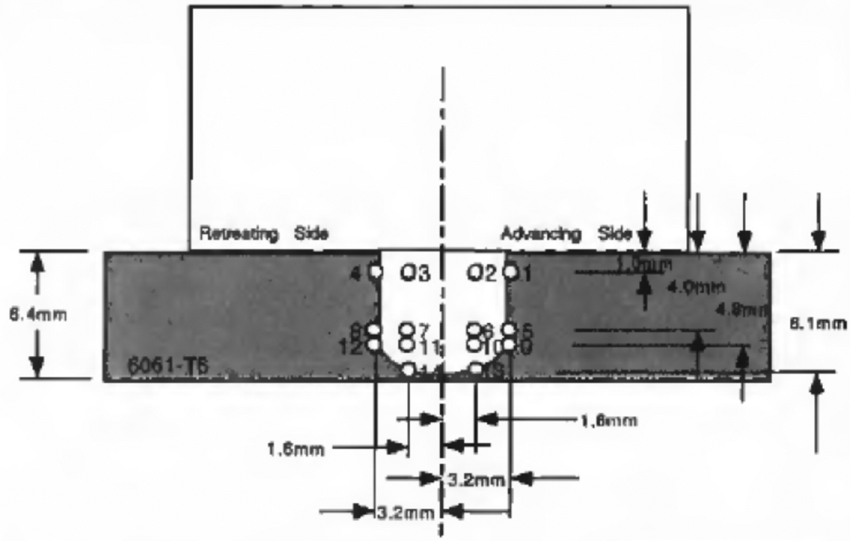
Figure 5: Tracer line positions for the 6.4 mm 6061-T6